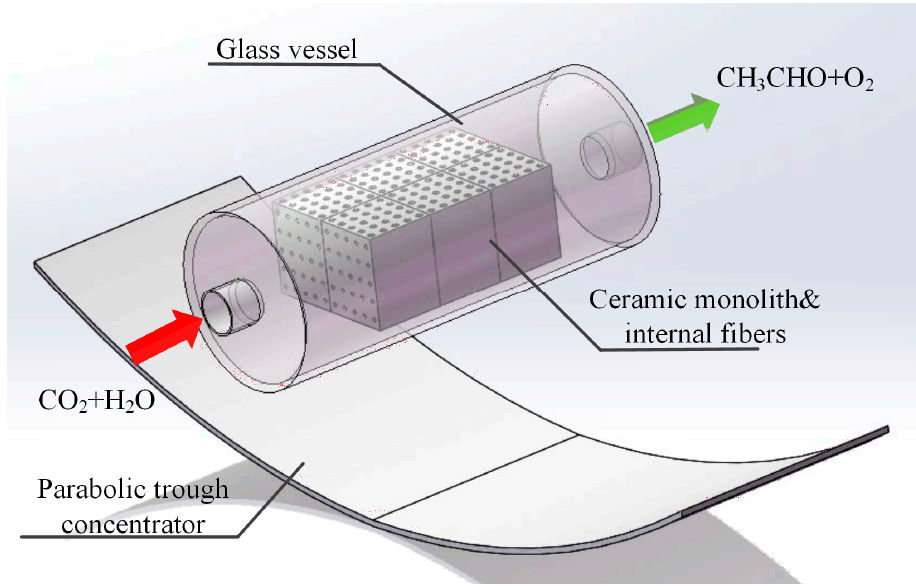
Figure 2. Schematics of OFMR coupled with PTC system.